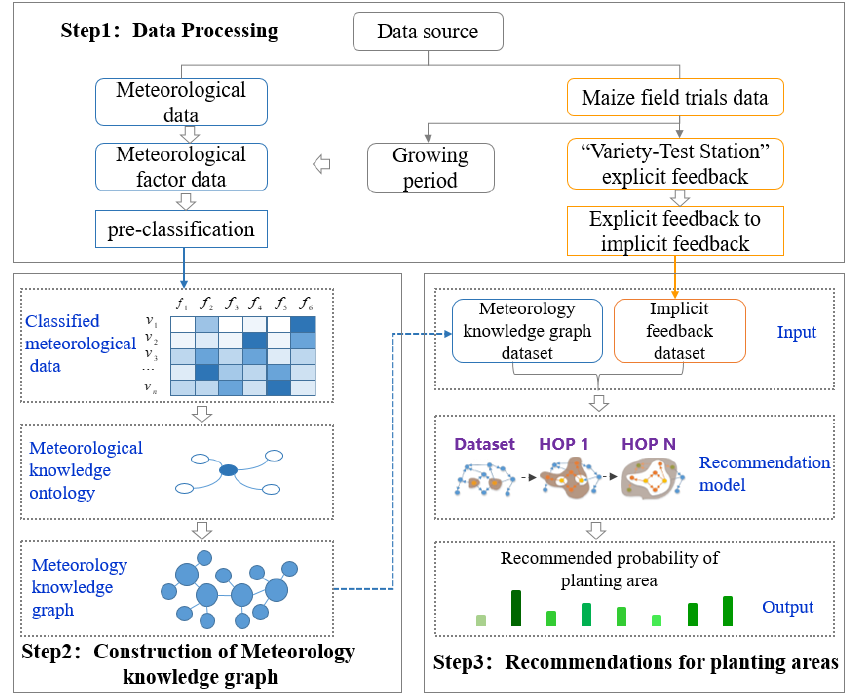
Figure 2. Overall flow chart of recommendation model based on knowledge graph.